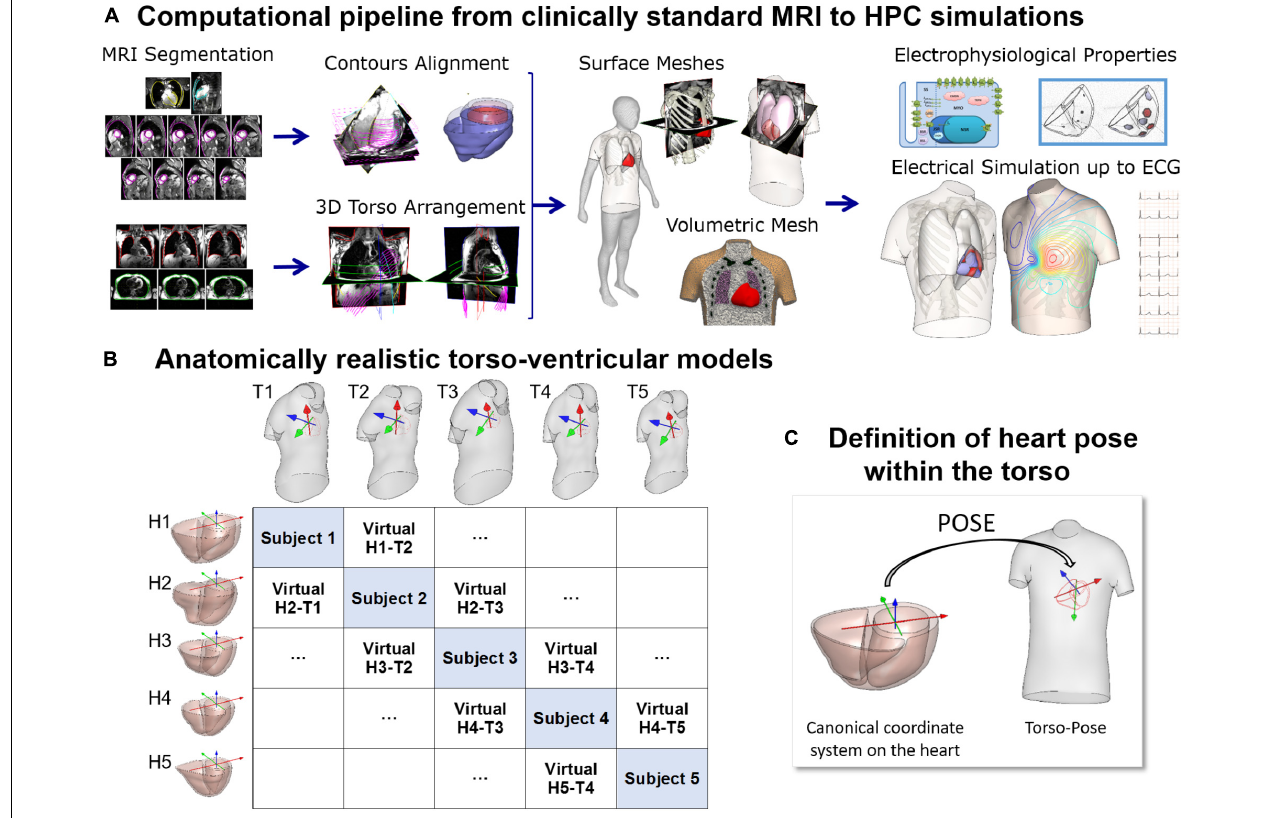
FIGURE 1 | (A) Computational pipeline from clinical MRI segmentations through construction of heart and torso geometries to the HPC simulation of electrophysiology from ionic to body surface potentials. Following MRI segmentations, heart surface is obtained by removing breath misalignment and torso surface by using the sparse information from the MRI contours together with a statistical body shape model. With the volumetric meshes, electrophysiological properties such as an action potential model and an activation model are used to simulate electrical activity from cell to torso and calculate the 12-lead ECG. (B) 25 torso-ventricular anatomical models combining five torsos (T1–T5) and five ventricles (H1–H5) of varying volumes. (C) Heart pose within the torso defined as the transformation from a canonical coordinate system of the ventricular geometry to the torso coordinate